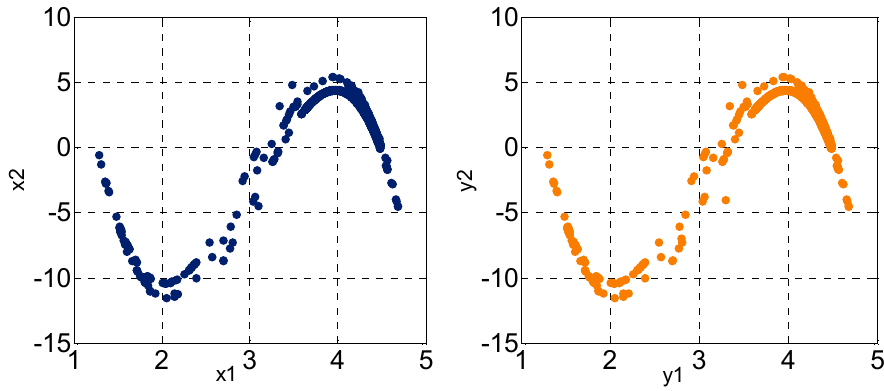
Figure 11. The phase planes of the controlled master and slave CRNGs.